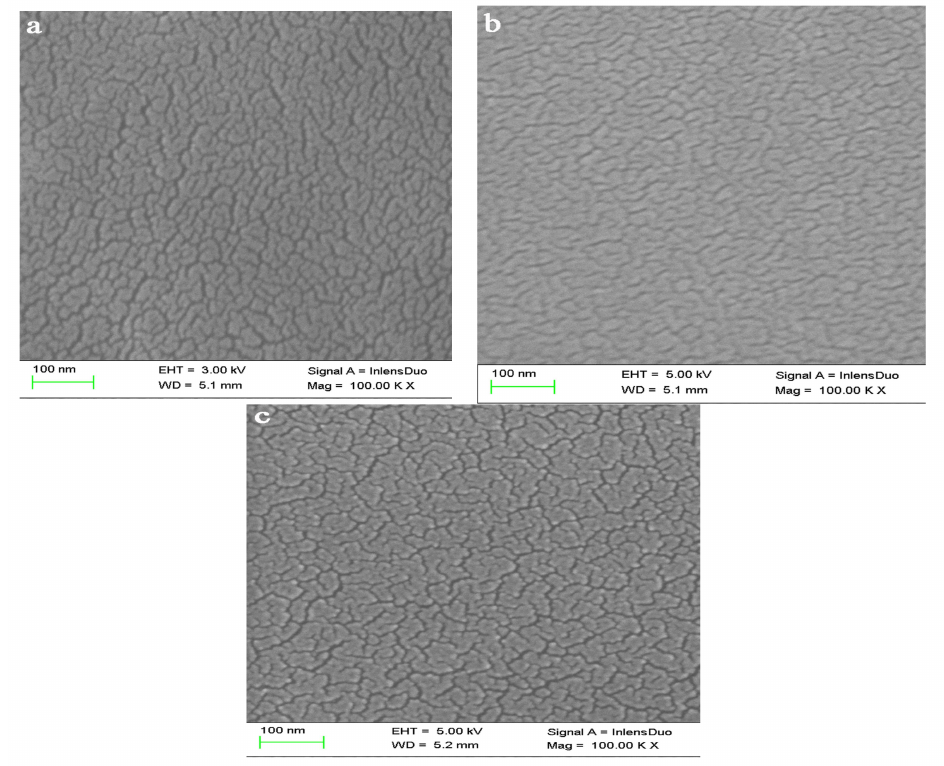
Figure 3. Scanning Electron Microscope (SEM) images of films of P1 ( a ); P2 ( b ); and P3 ( c